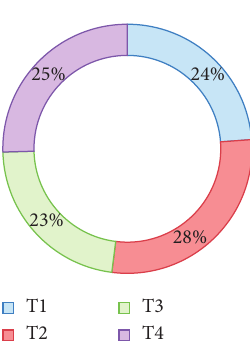
Figure 5: Loop comparison chart of SVITC for T1, T2, T3, and